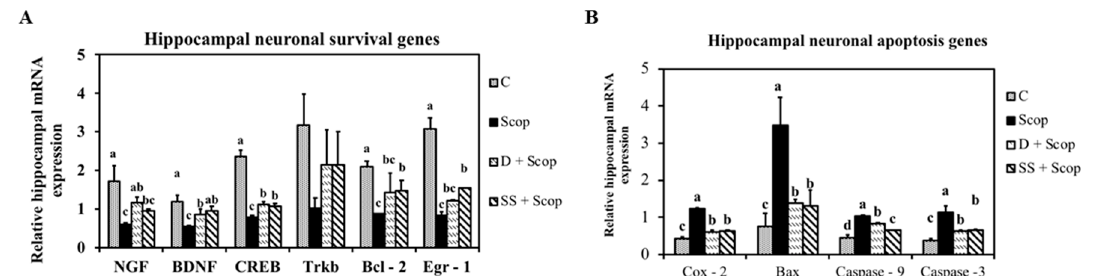
Figure 6. Effect of Stachys sieboldii in the mRNA expression of hippocampal neuronal survival genes ( A ) and neuronal apoptosis genes ( B ) All values are mean ± SD ( n = 4). Mean with different superscripts in the same row such as a, b indicates significant difference by ANOVA with Tukey’s test at p < 0.05 compared to control group.